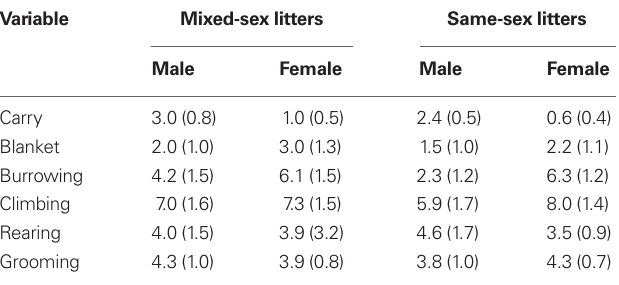
Table 4 | Mean ( ± SEM) total frequencies of each behavior across 10-min sessions conducted on PN10.